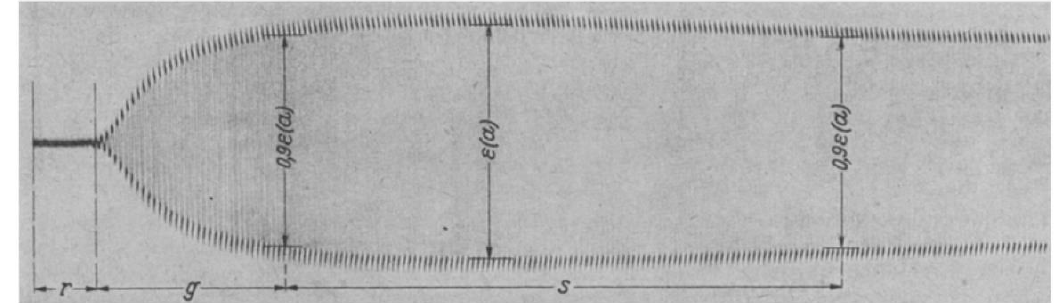
Figure 3. Output from Dr Hartert’s cup and pin. Representation of the output from the entire cycle of the cup and pin system. The R period was described as the reaction time, g as the growth of the clot and s as the stable period clot strength. The amplitude of the waveform is proportional to the shear modulus of the clot within its elastic region and is analogous to clot strength. Reproduced with permission from [5].